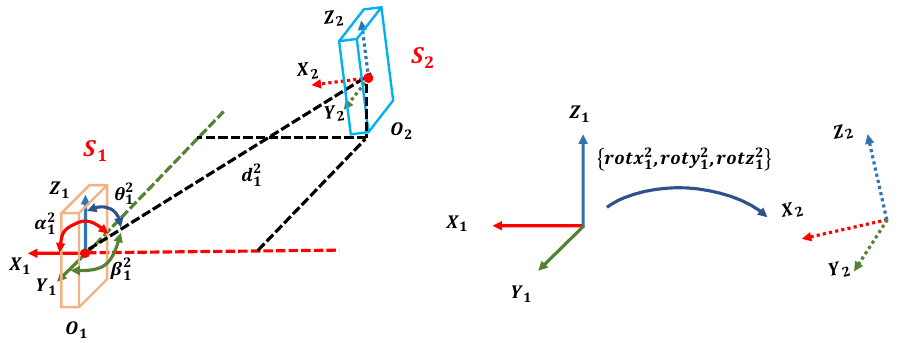
) } . S 2 is the , α 2 , β 2 , θ 2 , rotx 2 , roty 2 , rotz 2 1 1 1 1 1 1 1 } are the included , β 2 , θ 2 1 1 1 } are the Euler angles , roty 2 , rotz 2 1 1 1